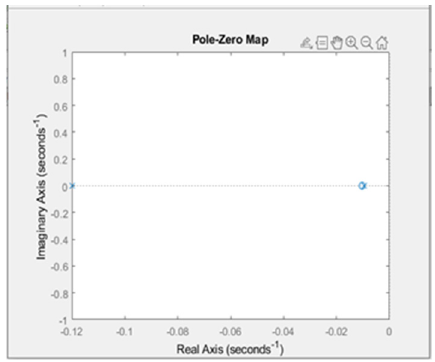
Figure 12. Pole zero diagram, two state variables.